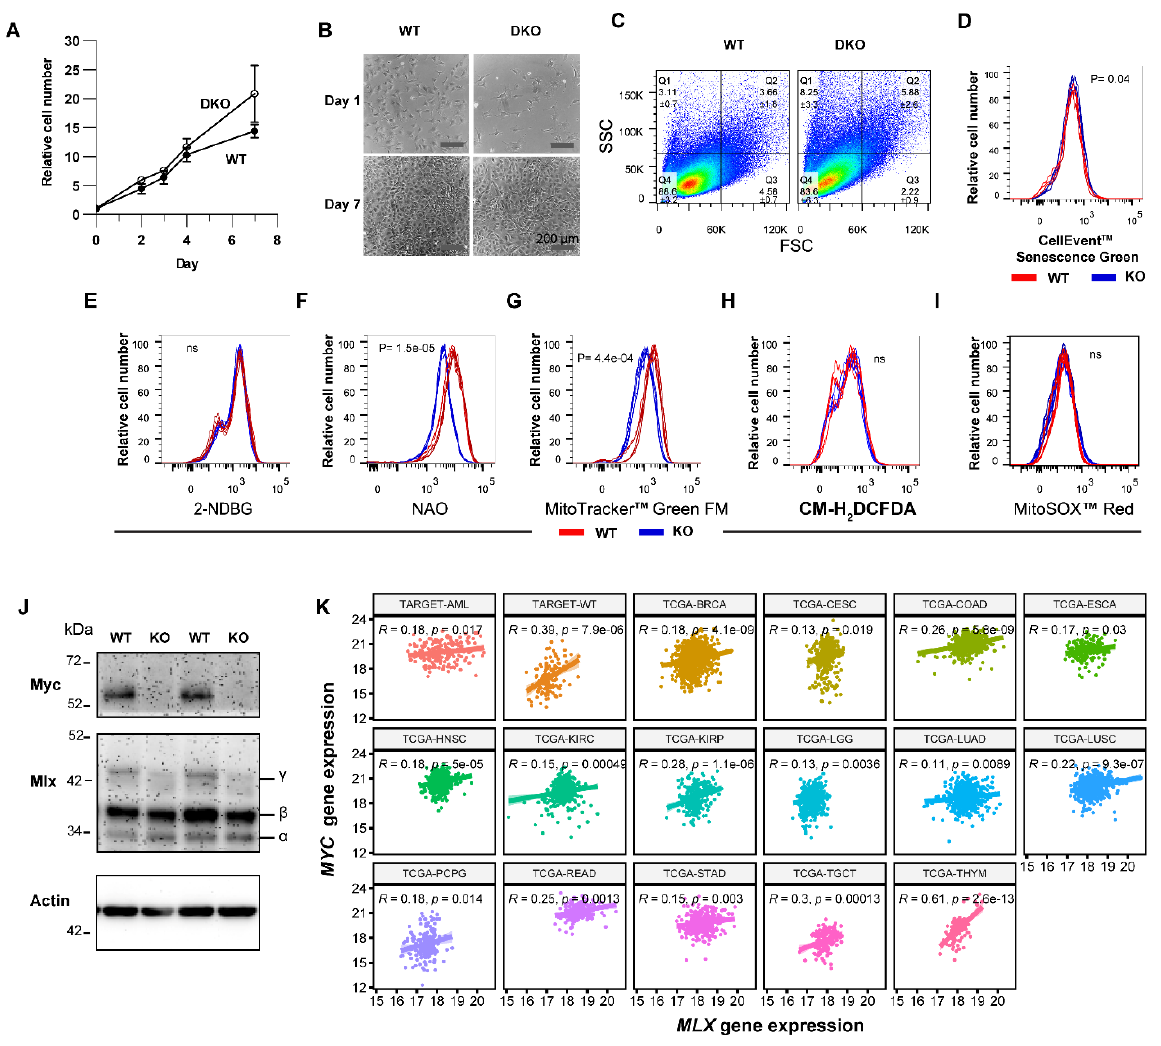
Figure 4. Correlations between Myc and Mlx expression: ( A ) WT and DKO MEFs were main- tained until day 28 and then re-plated at low density. Growth rates and p -values were determined from three replicates at the indicated times, as described in Figure 1E–G. ( B ) Phase-contrast micro- graphs of WT and DKO MEFs on days 29 and 36 (i.e., 1 and 8 days after re-plating, respectively). ( C ) Side- and forward-scatter of WT and DKO cells performed on ~day 43, as described in Figure 3A. ( D ) CellEvent TM Senescence Green staining performed on ~day 43, as described in Figure 3C. ( E ) 2-NBDG uptake by ~day 43 WT and DKO MEFs, performed as described in Figure 3B. ( F , G ) NAO and MitoTracker™ Green staining, respectively, performed on ~day 43–45 MEFs, as described in Fig- ure 2C. ( H , I ) CM-H2DCFDA and MitoSOX staining, respectively, performed on ~day 43–45 MEFs, as described in Figure 2E,F. ( J ) Selective loss of the γ isoform of the Mlx protein in immortalized Myc − / − rat fibroblasts, and its retention in the parental Myc +/+ cells from which they were derived [15]. ( K ) Correlations between Myc and Mlx transcript levels in 17 different cancer types from TCGA and the pediatric cancer TARGET collections. Pearson’s correlation coefficients and p -values are shown within each